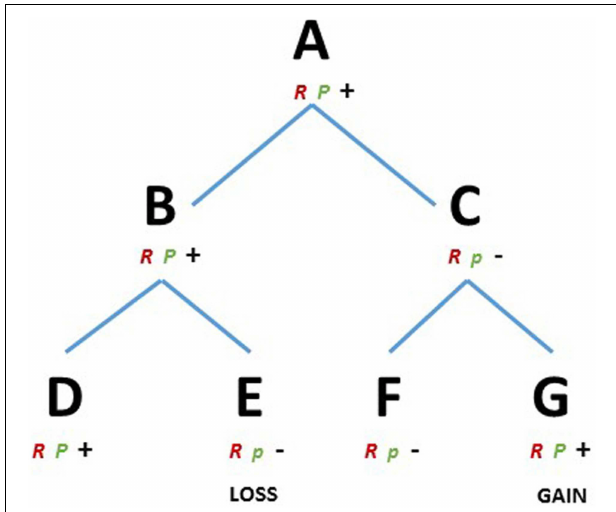
FIGURE 1 | RP theoretical framework. D, E, F, and G represents existing metazoans species and A, B and C their ancestors, respectively. R, robust module; P, plastic module, majuscule, and minuscule represents two variants of the module P. Plus and minus represents the capacity or the lack of regenerative ability,